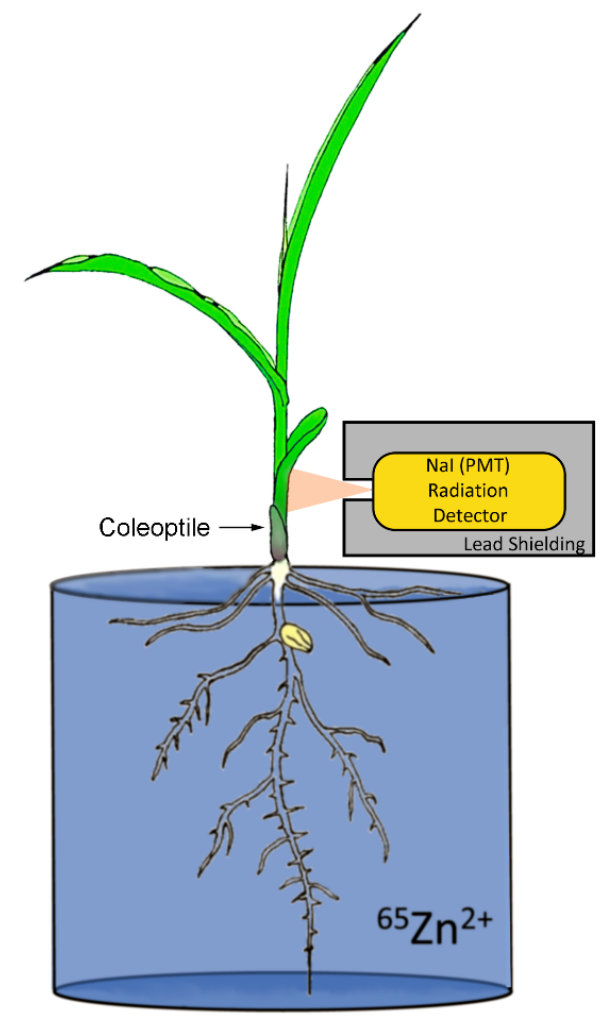
Figure 1. Experimental setup used for plant 65 Zn uptake studies. During exposure to radiotracer, plants were maintained at a constant 500 μ mol m − 2 s − 1 light intensity and 21 °C temperature.